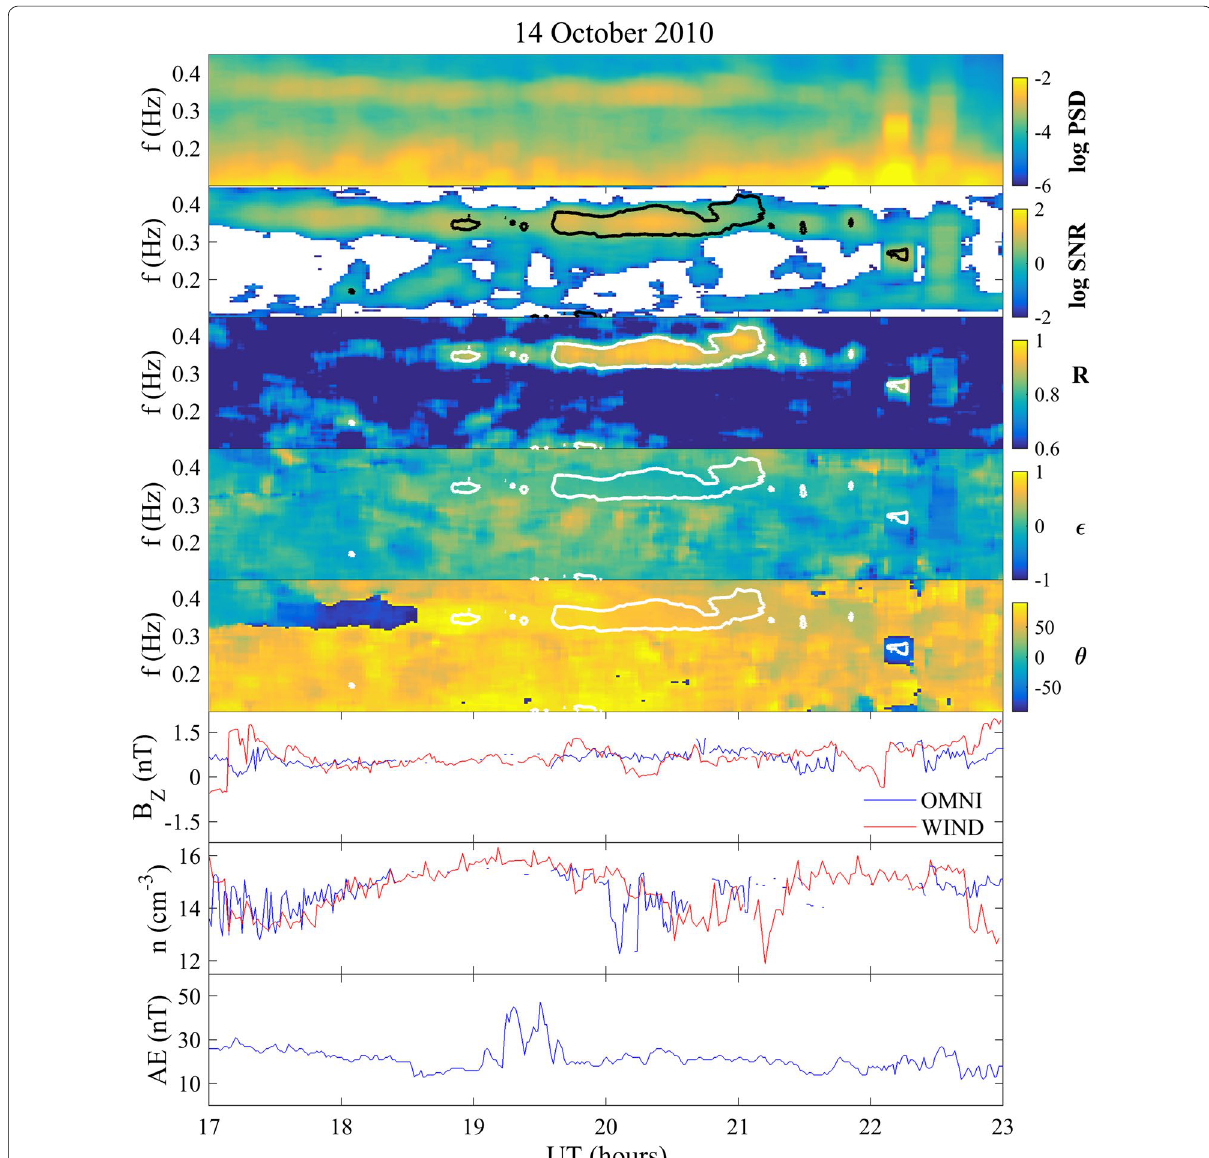
Fig. 13 Noon case study. The dynamical power spectrum, signal-to-noise ratio (white areas correspond to SNR < 0), polarization ratio, ellipticity, azimuthal angle, IMF B z component, SW density, and AE index during the October 14, 2010, event. In addition to the OMNI data (blue line), which show large gaps, the WIND data are also plotted (red line). Black and white contours encircle values corresponding to a polarization ratio R >